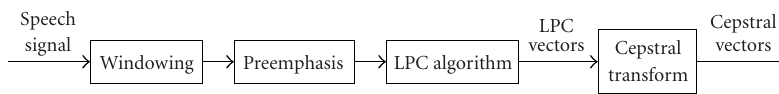
Figure 4: Modular representation of an LPC-based cepstral